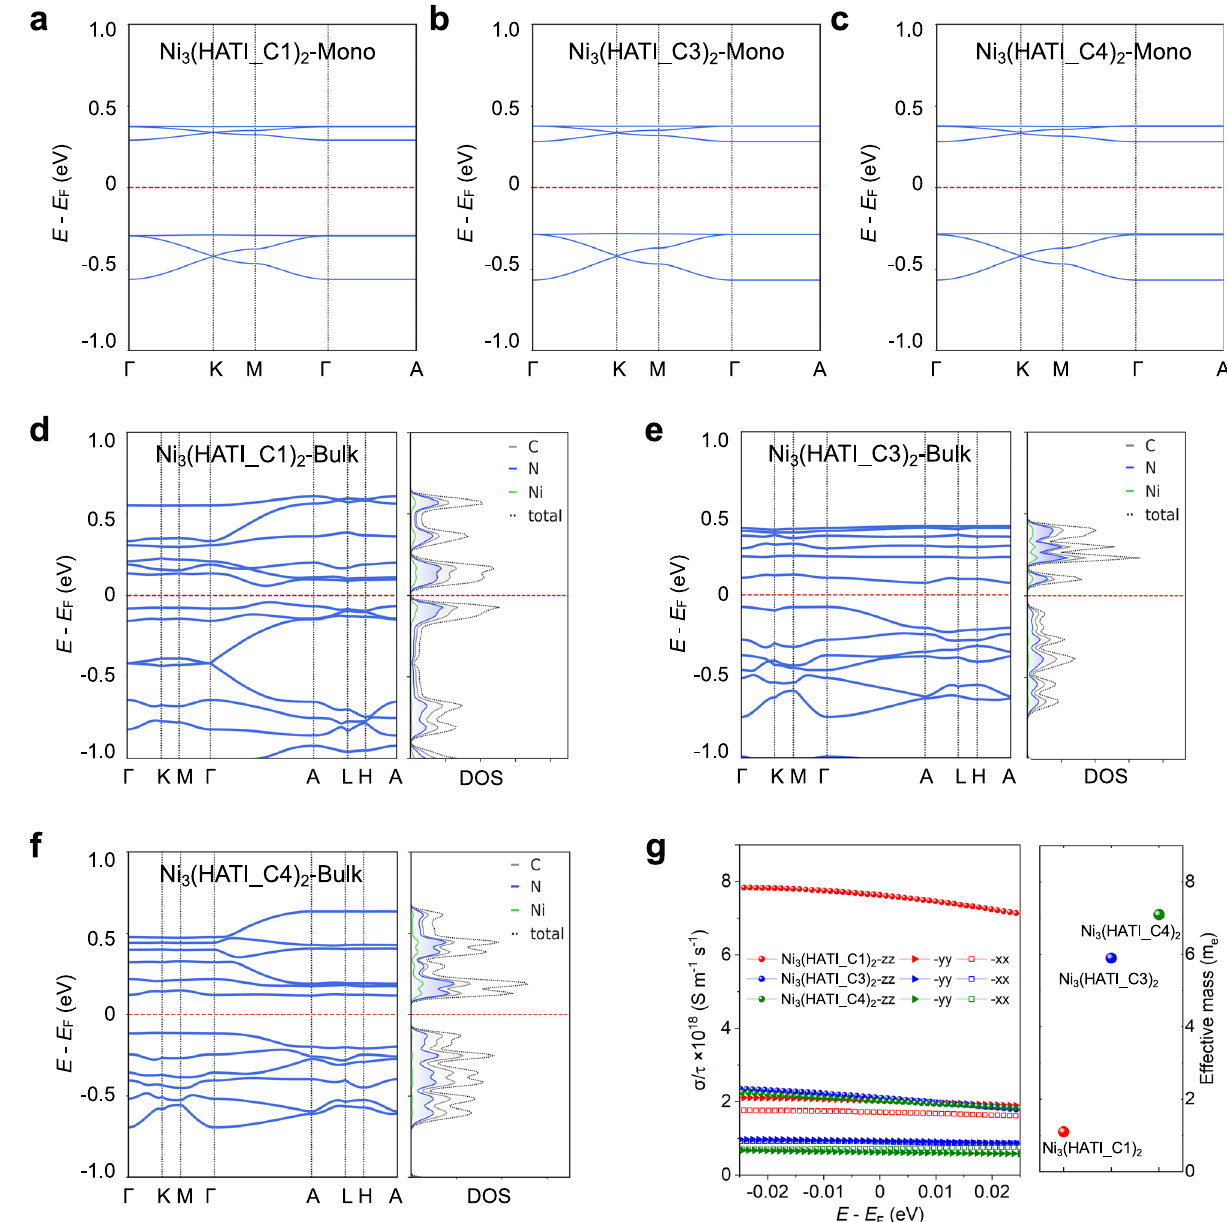
Fig. 2 | Theoretical calculation of electronic structures and conductivities for 2Dc-MOFs. ModelingoftheelectronicstructuresofNi 3 (HATI_CX) 2 .Thecalculated band structures of monolayer a Ni 3 (HATI_C1) 2 , b Ni 3 (HATI_C3) 2 , and c Ni 3 (HATI_C4) 2 . The calculated band structures and projected density of